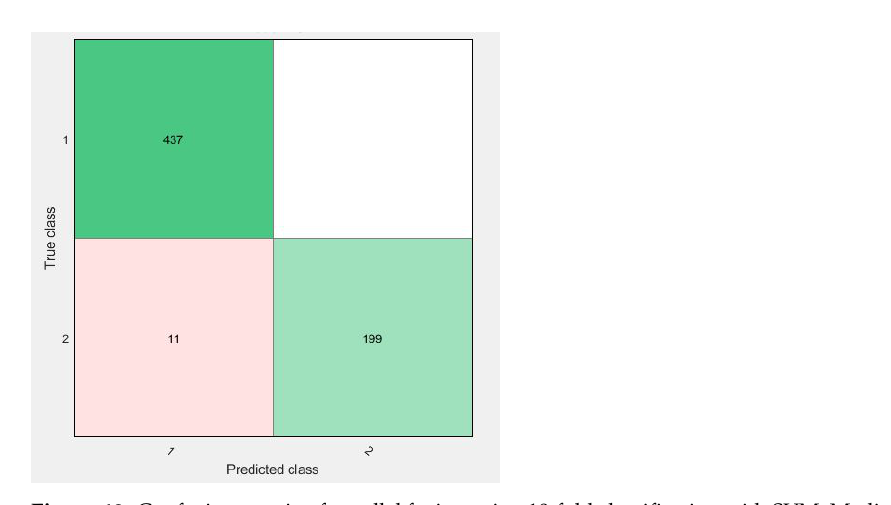
Figure 12. Confusion matrix of parallel fusion using 10-fold classification with